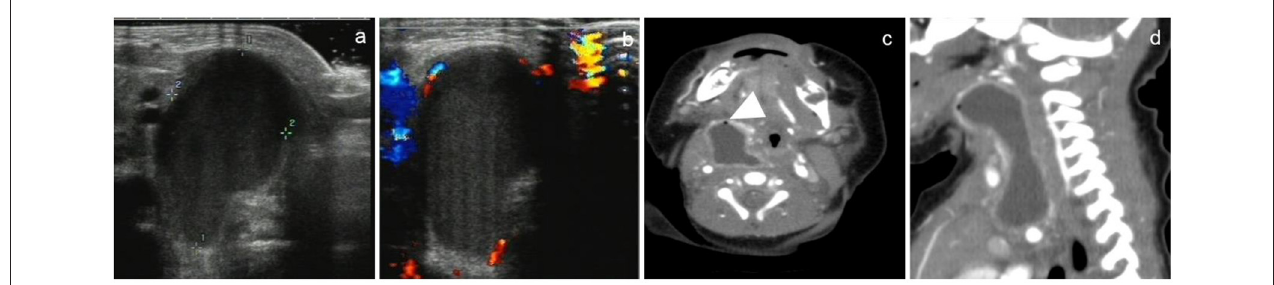
FIGURE 3 | A 15-day-old female newborn with CPSF on the right neck. US and CT showed a non-septal cystic mass in the right neck. US showed an inhomogeneous mass with low echogenicity, in which there were no air bubbles (a) . Color Doppler showed there was no blood flow sonogram in the cyst (b) . CT showed that the cyst wall was thick and high attenuation, the border of the cyst was poorly defined, and tiny air bubbles could be seen in the cyst (arrowhead). The cystic mass extended laterally into the retropharyngeal space (c) and longitudinally into the anterior mediastinum (d) .